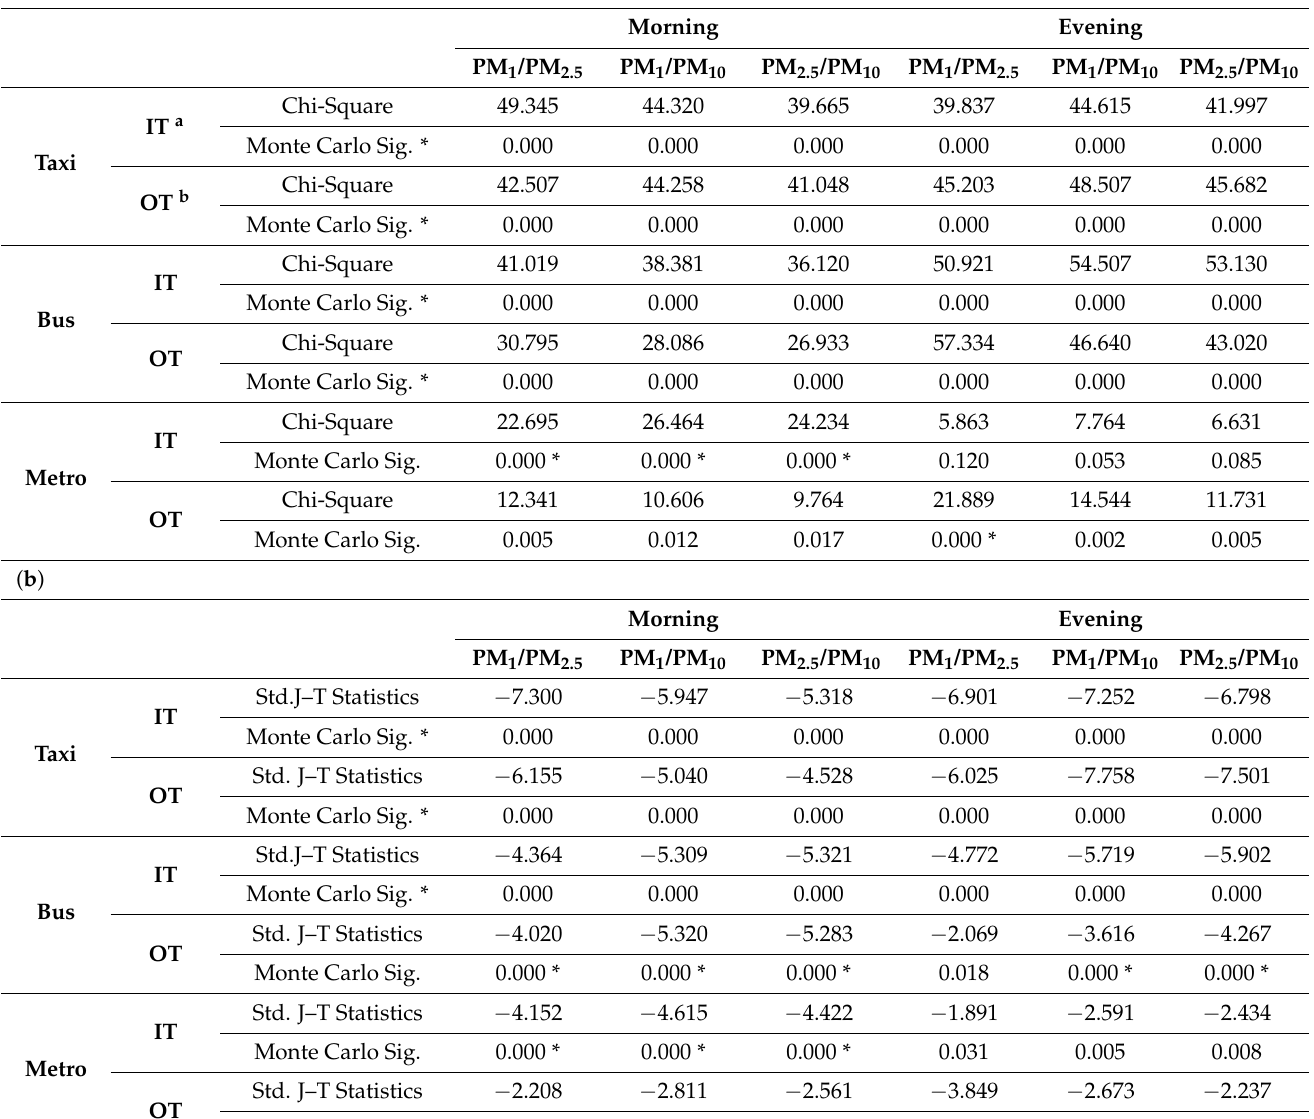
Table 3. Kruskal–Wallis (K–W) and Jonckheere–Terpstra (J–T) tests for variations in ratios of in-cabin particulate matter concentrations among cities for each travel mode. (a) Kruskal–Wallis Test